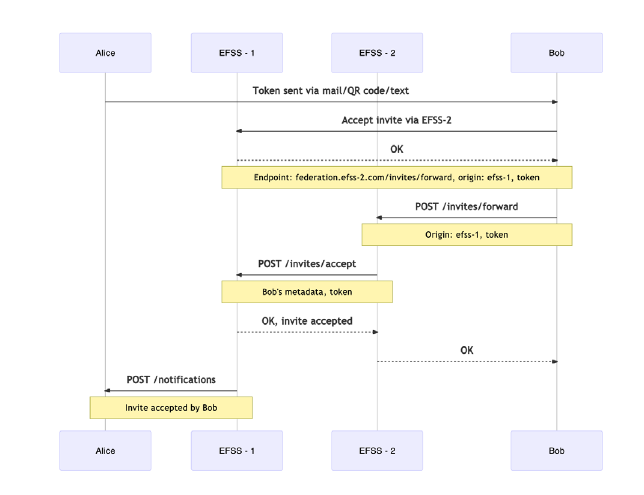
Figure 2. Creating and accepting invites to initiate OCM